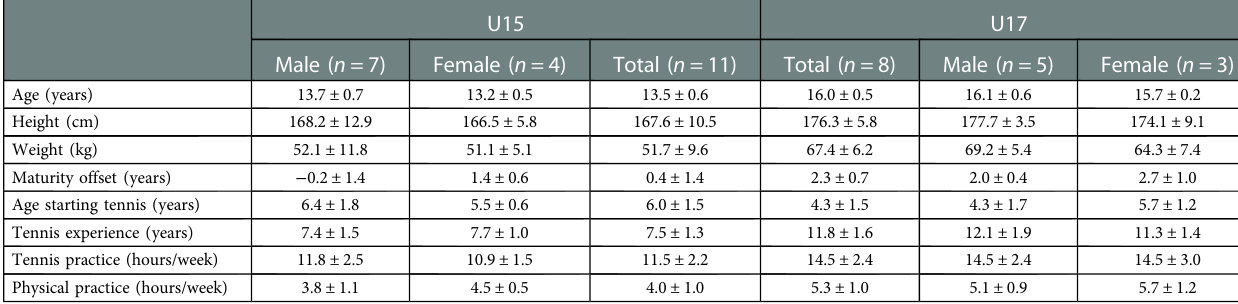
TABLE 1 Descriptive statistics (mean±SD) of talented youth tennis players ( n